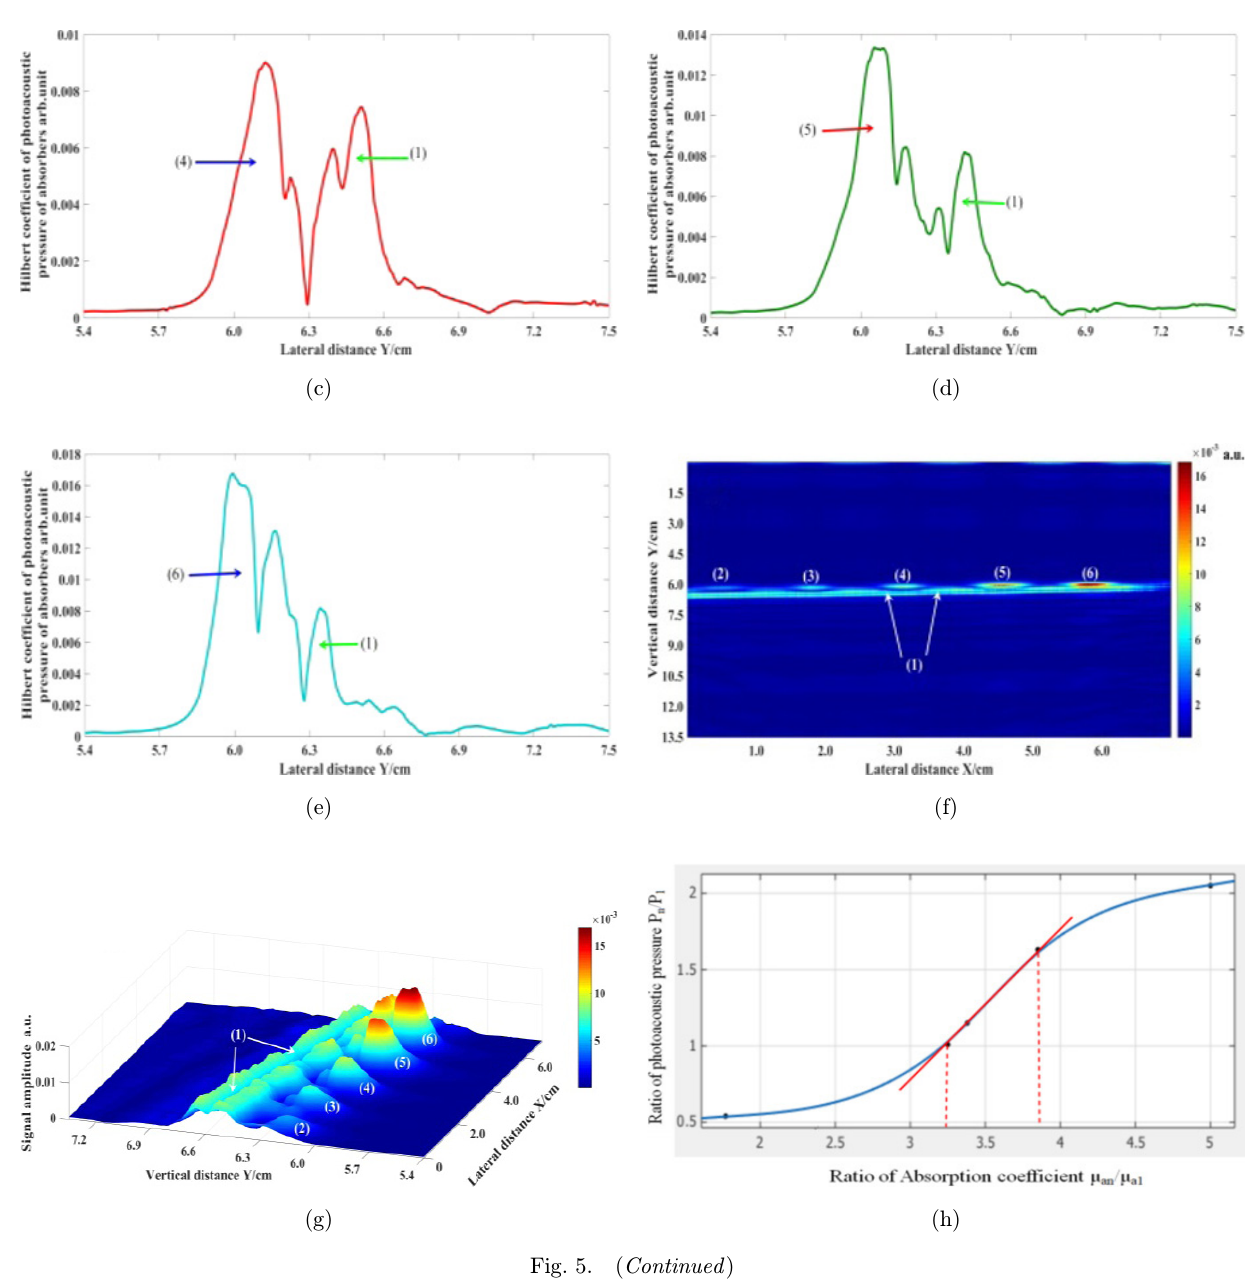
from 2D PAI, which were exempli¯ed by transversal detection results of gastric tumor in Fig. 6(e). The signal-to-noise ratio of Fig. 6(e) was 85.95 db. Figure 6(d) shows the Gaussian ¯tting result for photoacoustic signals of three simulated tumors. We calculated the width (full width at half maximum-FWHM) of three simulated tumors in Fig. 6(d) were (4 : 4 (cid:3) 0 : 1) mm, (5 : 4 (cid:3) 0 : 4) mm, (4 : 6 (cid:3) 0 : 4) mm, respectively, which corresponded well with the actual size. Partial